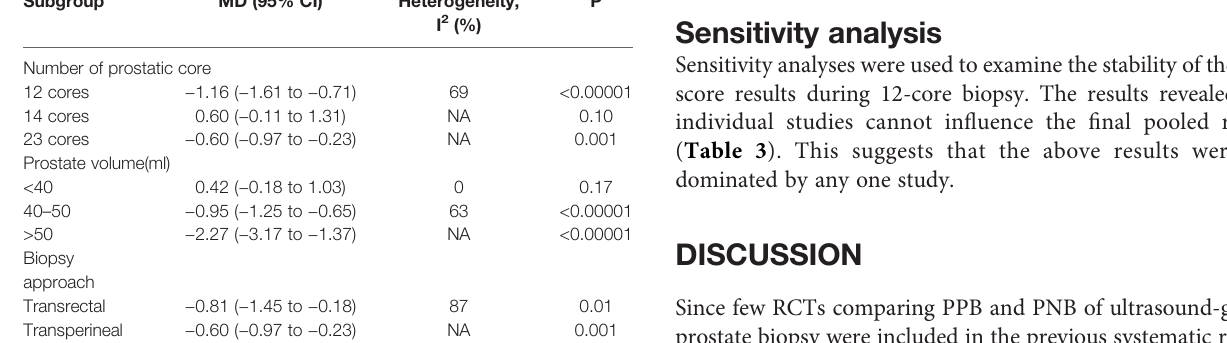
TABLE 2 | Subgroup analysis of prostate biopsy by number of prostatic core, biopsy approach, or prostate volume.